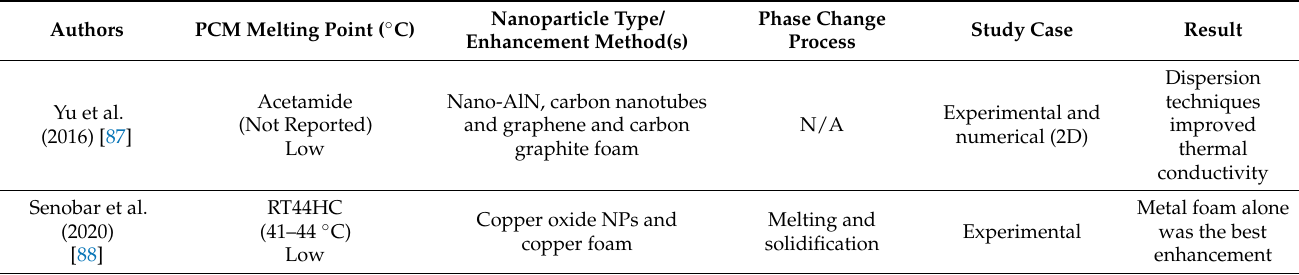
Table 4. A summary of studies that used NePCM combined with highly conductive porous media to enhance the thermal performance of LHTES